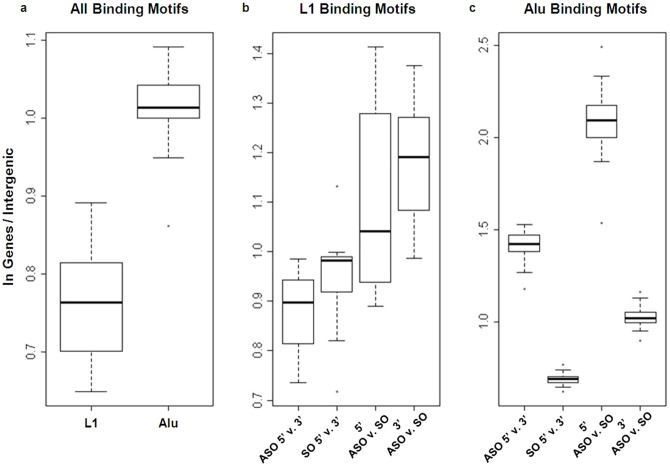
Depletion of motifs within RTs is dependent on position and orientation within the gene.The frequency in genes versus intergenic for all binding motifs (a), frequency of binding motifs contained within L1 (b), frequency of binding motifs contained within Alu (c). Calculations for b and c were restricted to the inner deciles with the largest and smallest antisense ratio respectfully, the 2nd (5′) and 9th (3′) deciles. The first two boxes show motifs present in the 2nd decile compared to the same motifs in the 9th decile for both the antisense orientation (ASO) and sense orientation (SO). The last two boxes restricted analysis to within the same bin and compared the motifs in the antisense orientation to the same motifs in the sense orientation.